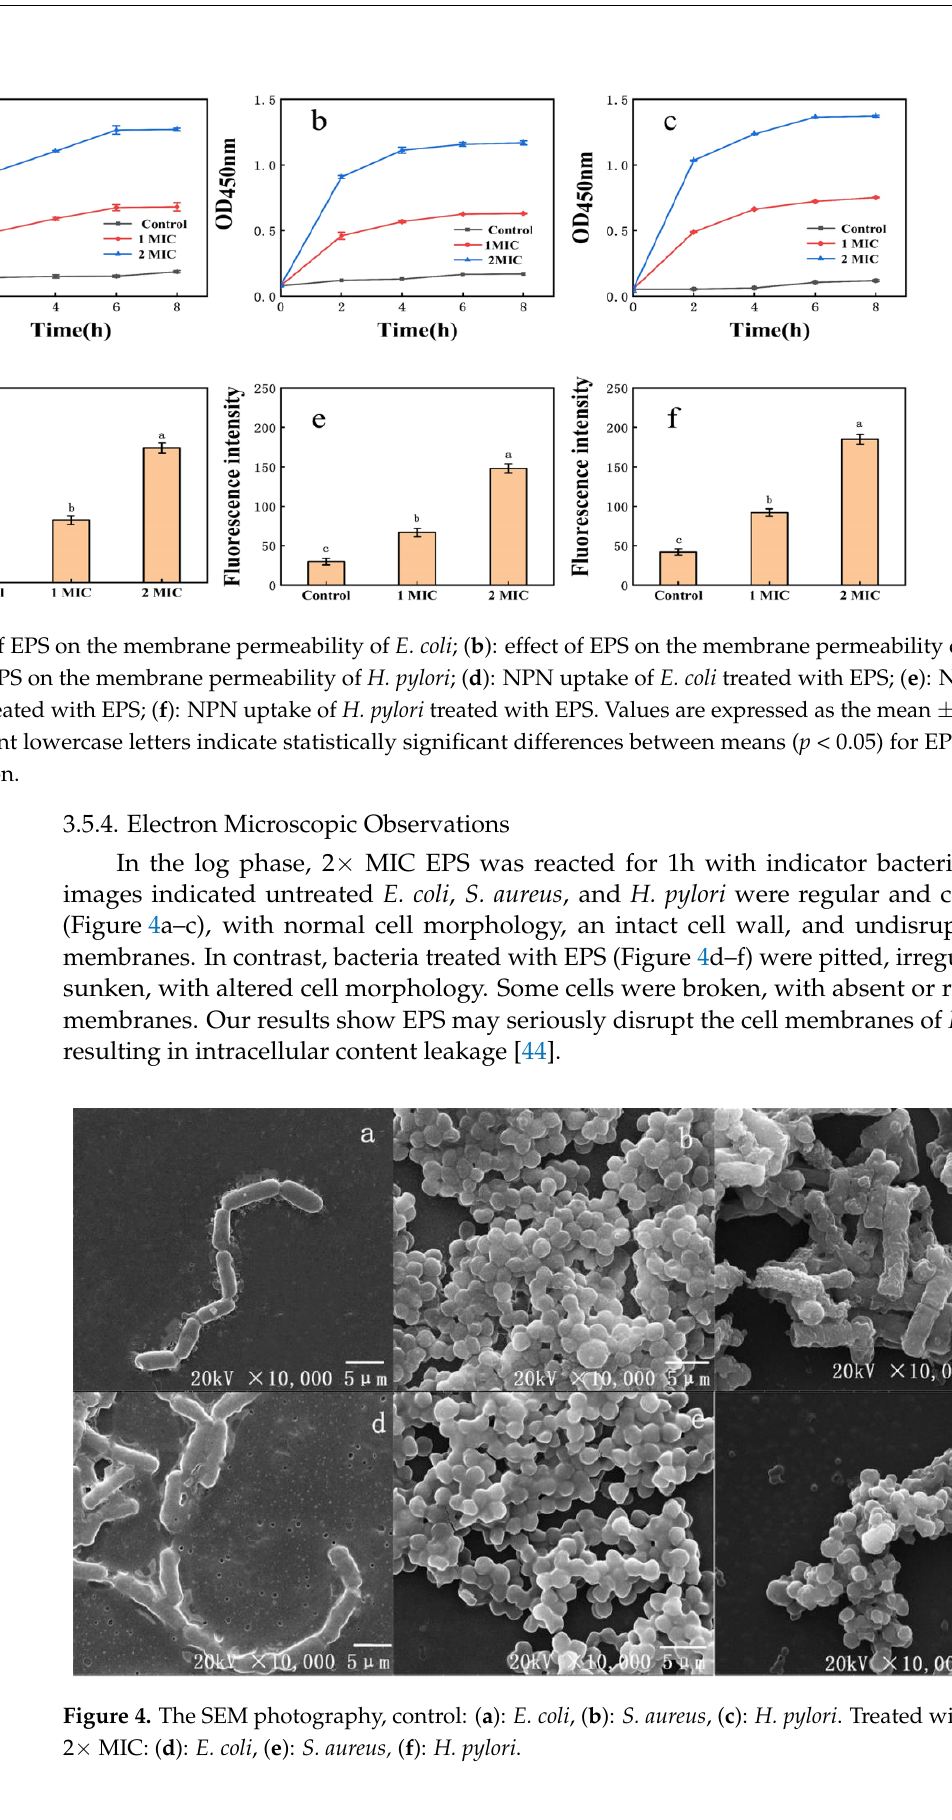
10 of 16 Table 4. Effects of EPS on cell components’ release of H. pylori. Indicator Bacteria